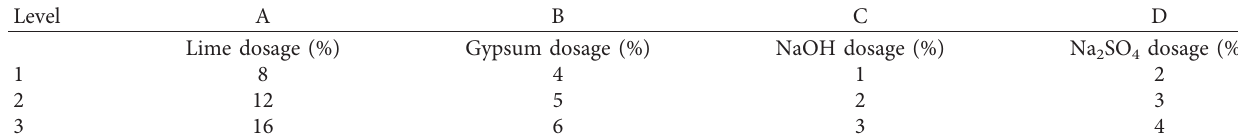
Table 4: Orthogonal table design of compound activation test.